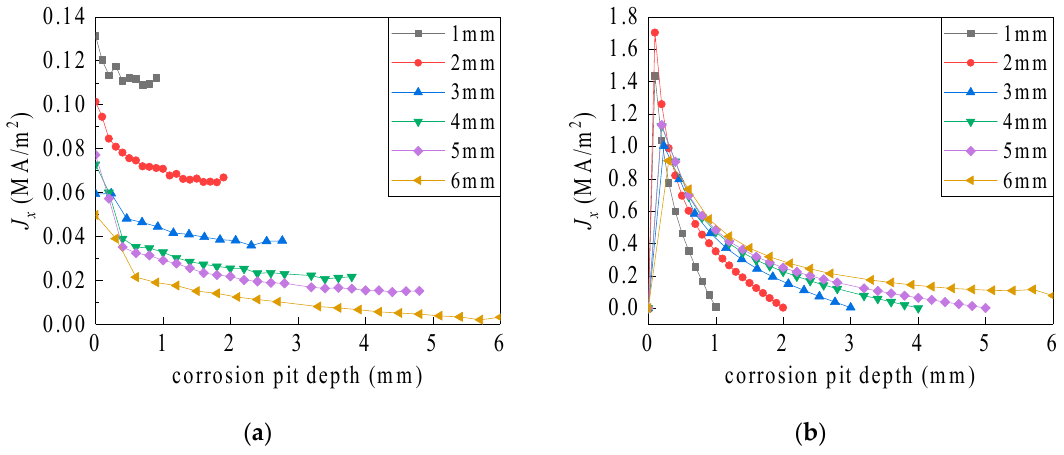
Figure 14. Current density distribution of the corrosion pit inner side. ( a ) Line a and ( b ) line b.